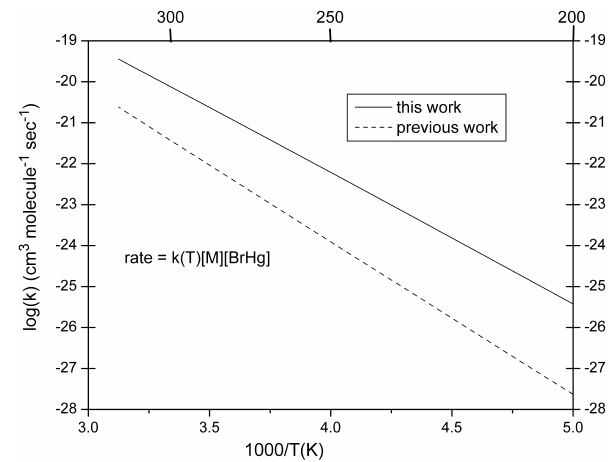
Fig. 2. Illustration of the temperature dependence of the rate con- stant for BrHg dissociation. The rate constant for dissociation is first order in [BrHg] and first order in [M]. Both values displayed use k (BrHg+M → Br+Hg+M) from Donohoue et al. (2006), but the previous work relies on the equilibrium constant implied by the work of Goodsite et al.